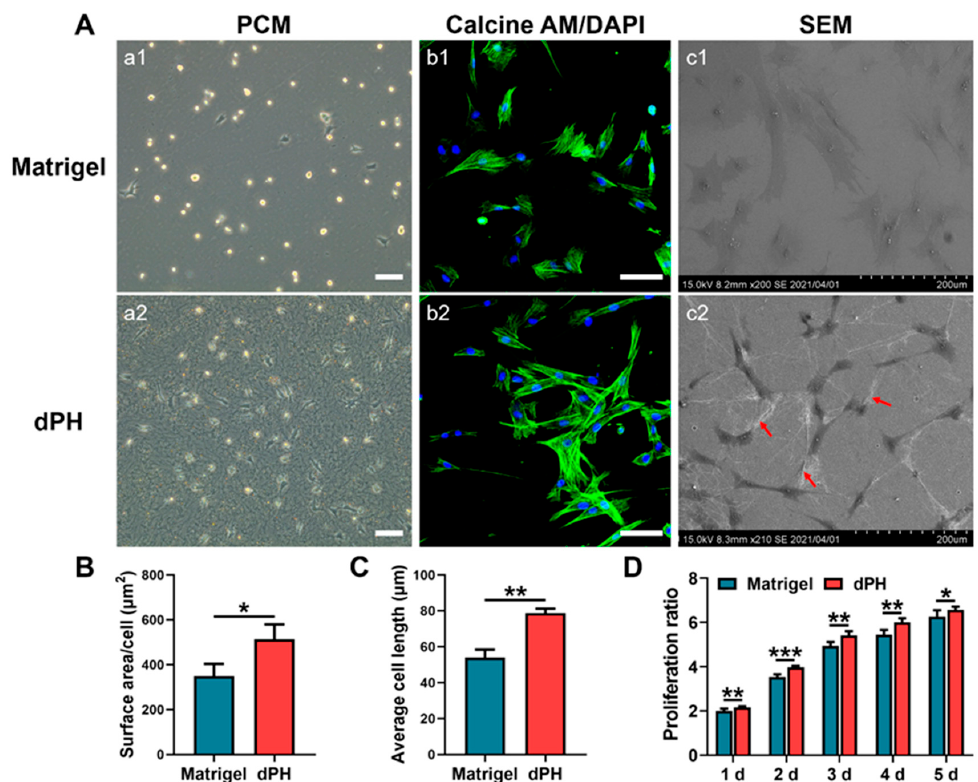
Figure 4. Morphological analysis and proliferation rate of hUCMSCs cultured on Matrigel and dPH. ( A ) Representative images of hUCMSCs cultured on Matrigel and dPH. (a1,a2) Phase contrast micrographs of hUCMSCs cultured on Matrigel and dPH for 24 h. (b1,b2) Cytoskeletal staining of hUCMSCs cultured on Matrigel and dPH for 48 h. (c1,c2) SEM images of hUCMSCs cultured on Matrigel and dPH for 48 h. The red arrows indicate nanofibers in dPH. ( B , C ) Cell surface area and length of hUCMSCs when being cultured on Matrigel and dPH for 24 h. ( D ) The proliferation rate of hUCMSCs when cultured on Matrigel and dPH. Scale bar = 100 μ m. * p < 0.05, ** p < 0.01, *** p < 0.001.